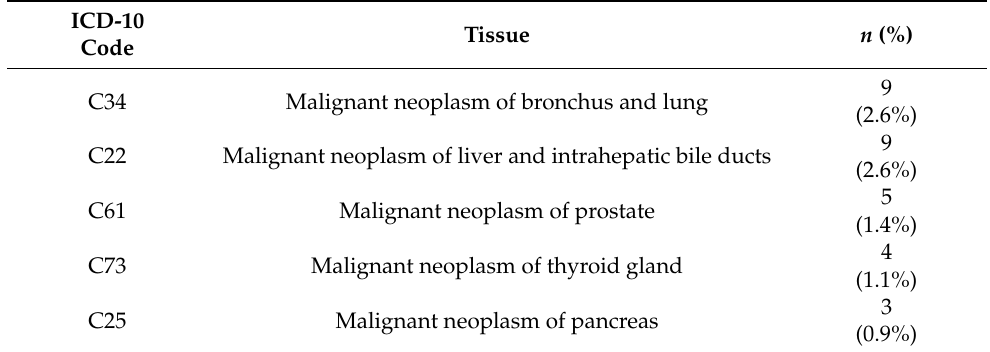
Table 2. Second primary cancers associated with uveal